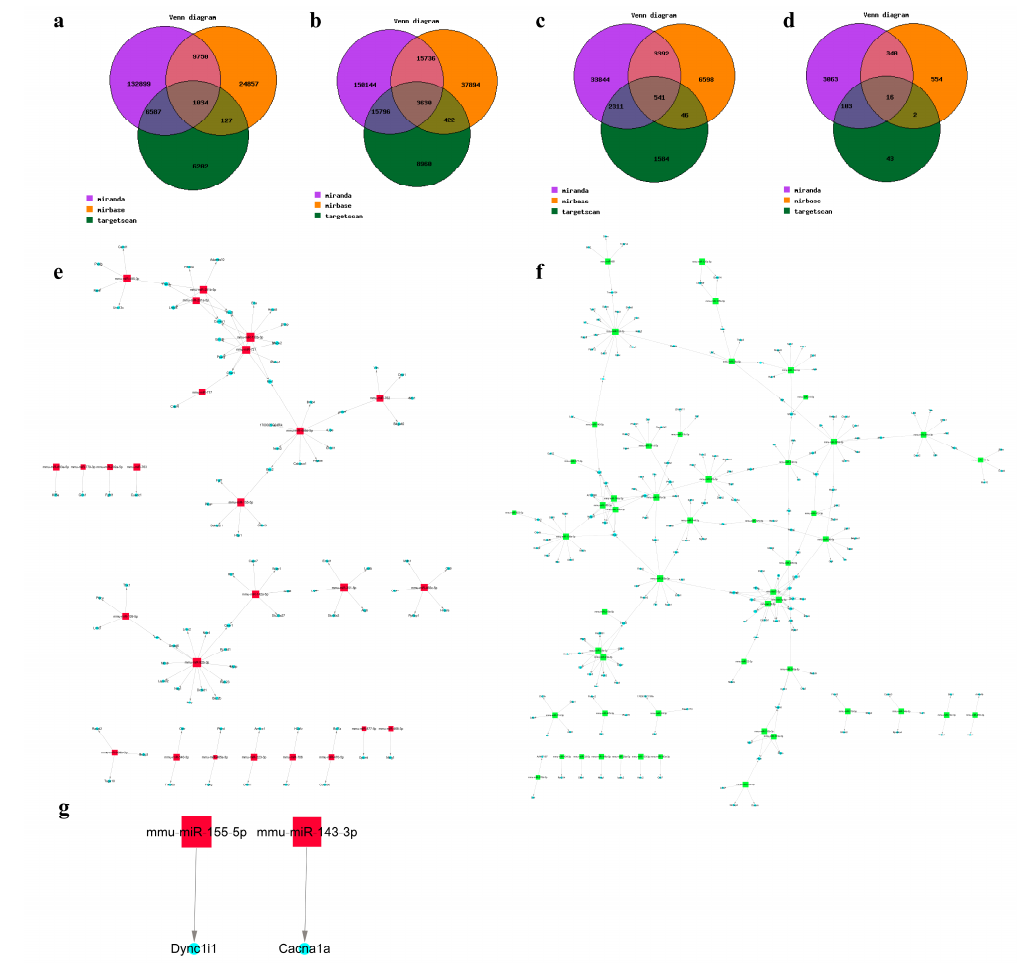
Figure 5. Potential mRNA targets of the differentially regulated miRNAs. ( a , b ) Venn diagrams show predicted targets of upregulated and downregulated miRNAs in AD elicitation by three integrated databases (miRanda, miRBase, and TargetScan). ( c , d ) Venn diagrams show predicted targets of upregulated and downregulated miRNAs in AD remission by three integrated databases. ( A :